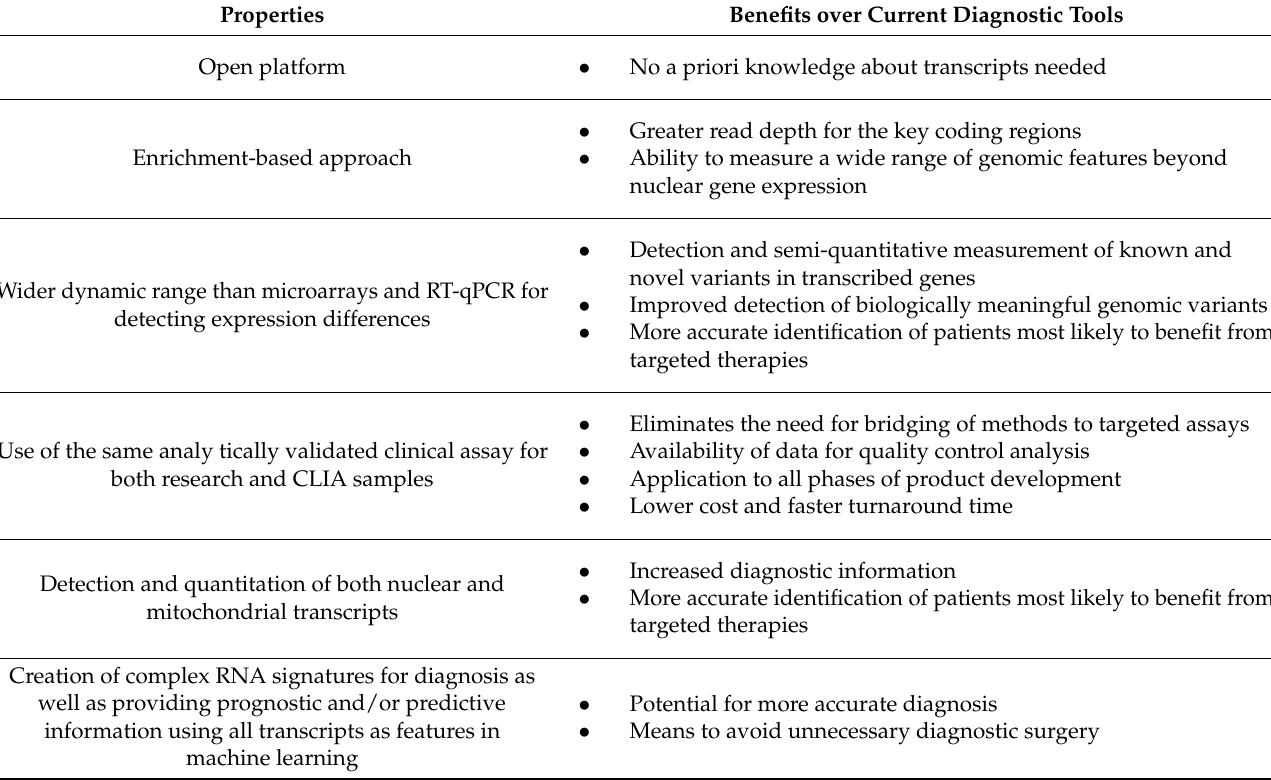
Table 2. Key properties of the Unified Assay